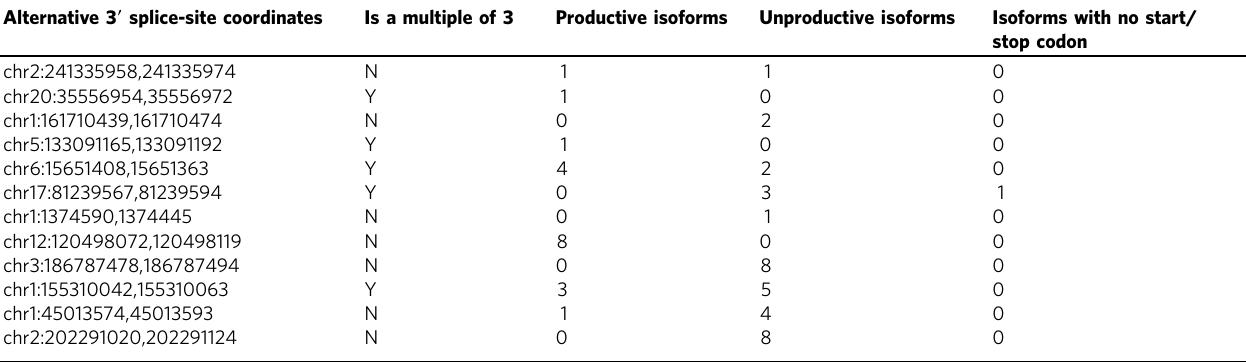
Thealternative3 ′ splicingevents displayedarethosewheretheproximalsplicesiteispreferredinSF3B1 K700E samples.Onlysplicingeventsthataffectcodingregionsareshown,andonlyisoformsusing the proximal splice site were counted. Isoforms were counted if they have a minimum of 20 counts across SF3B1 K700E